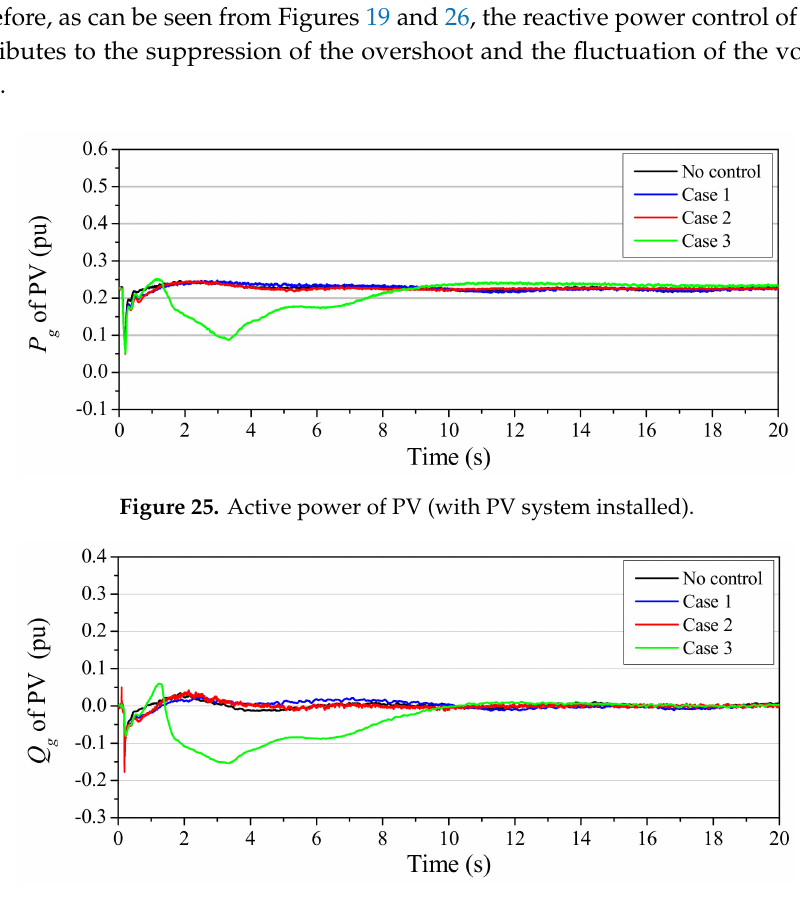
Figure 26. Reactive PV power (with PV system installed).